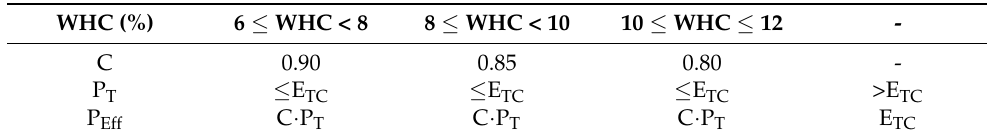
Table 3. Determination of the coefficient of efficient precipitation.